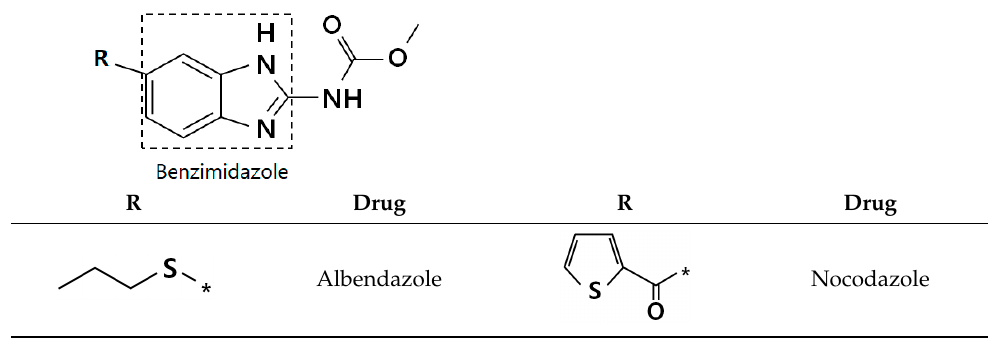
Figure 1. Schematic diagram of anti-cancer mechanisms of benzimidazoles. ( A ) Effects of benzimidazoles on cancer cell death, ( B ) Anti-angiogenic and anti-metastatic effects of benzimidazoles, ( C ) Inhibitory effects of benzimidazoles on cancer stemness. Abbreviations: Mdm2: mouse double minute 2 homolog; MdmX: mouse double minute 4; RAF: rapidly accelerated fibrosarcoma; MEK: mitogen-activated protein kinase; ERK: extracellular signal-regulated kinases; PI3K: phosphatidylinositol 3-kinase; AKT: protein kinase B; LC3: microtubule-associated protein 1 light chain 3; mTOR: mammalian target of rapamycin; PARP: poly(ADP-ribose) polymerase; Bax: B-cell lymphoma 2 (Bcl-2)-associated X protein; Bcl-2: B-cell lymphoma 2; Bcl-xL: B-cell lymphoma extra-large; VEGF: vascular endothelial growth factor; HIF: hypoxia-inducible factor; STAT3: signal transducer and activator of transcription 3; BCSC: breast cancer stem cell. Table 1. Chemical Structures of Benzimidazoles.